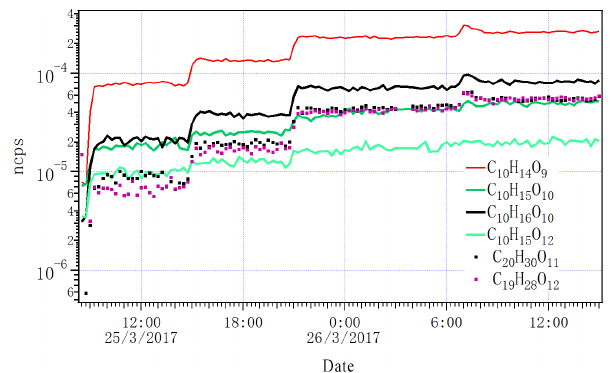
Figure 6. Time series of selected closed-shell HOM monomers, dimers and two RO 2 radicals (C 10 H 15 O 10 and C 10 H 15 O 12 ) de- tected by NO 3 -CI-APi-ToF as the lights increased from zero to one, two, four and seven. ncps stands for normalized counts per